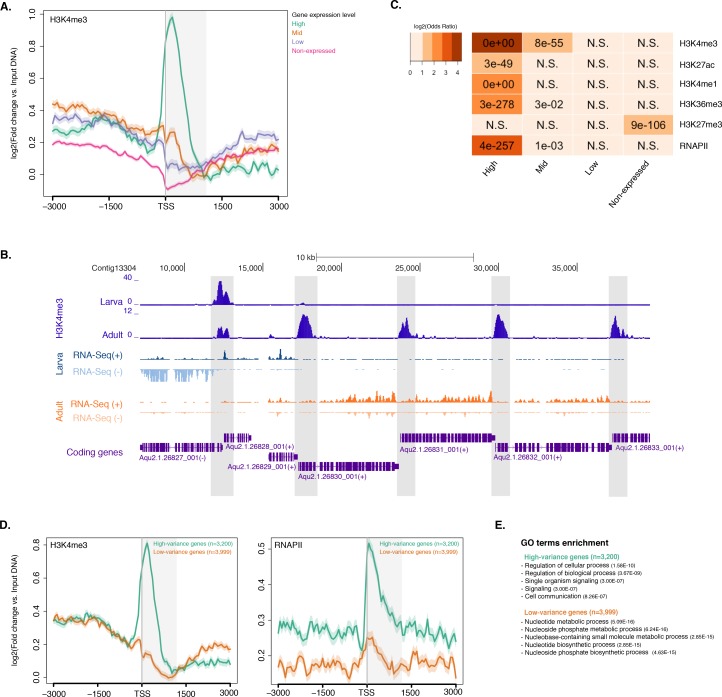
Histone PTMs are correlated with gene expression variations during development.(A) TSS-centred average input DNA normalised read coverage plot of H3K4me3 across Amphimedon protein-coding genes. The x-axis spans ± 3 kb around TSSs and represents the position within the gene relative to TSS. The y-axis represents the input DNA normalised enrichment for H3K4me3 ChIP-seq reads in adult Amphimedon. Pink line: Non-expressed genes. Blue line: Low expressed genes. Orange line: Medium expressed genes. Light blue line: High expressed genes. The shaded gray area represents the average size of Amphimedon coding sequences. (B) Example of coding genes marked by H3K4me3 peaks. The genomic window shows input DNA-normalized H3K4me3 coverage and RNA-seq expression in both larva and adult. (C) The association of regions of enrichment of five histone H3 PTMs (H3K4me3, H3K27ac, H3K4me1, H3K36me3 and H3K27me3) and RNAPII with lists of various gene expression groups in adult is shown. The color key represents the log2(odds ratio) and the significant adjusted P-values (Fisher’s exact test) are superimposed on the grids. A P-value of zero means the overlap is highly significant. N.S.: not significant. Odds ratio represents the strength of association. (D) TSS-centred average input DNA normalised read coverage plots of H3K4me3 and RNAPII across ‘high-variance’ and ‘low-variance’ protein-coding genes. The x-axis spans ± 3 kb around TSSs and represents the position within the gene relative to TSS. The y-axis represents the input DNA normalised enrichment for ChIP-seq reads in adult Amphimedon. Light blue: high-variance coding genes. Orange line: low-variance coding genes. The shaded gray area represents the average size of Amphimedon coding sequences. (E) Top five most significantly enriched Gene Ontology (GO) terms for high-variance and low-variance protein-coding genes (adjusted P-values in brackets, Hypergeometric test). The full GO table is shown in Figure 2—source data 1.DOI:
http://dx.doi.org/10.7554/eLife.22194.01310.7554/eLife.22194.014Figure 2—source data 1.GO biological process term enrichment outcome for the high-variance and low-variance gene sets (Hypergeometric test, FDR<0.01).DOI:
http://dx.doi.org/10.7554/eLife.22194.01410.7554/eLife.22194.015Figure 2—source data 2.KEGG pathways significantly enriched in low-variance and high-variance genes.